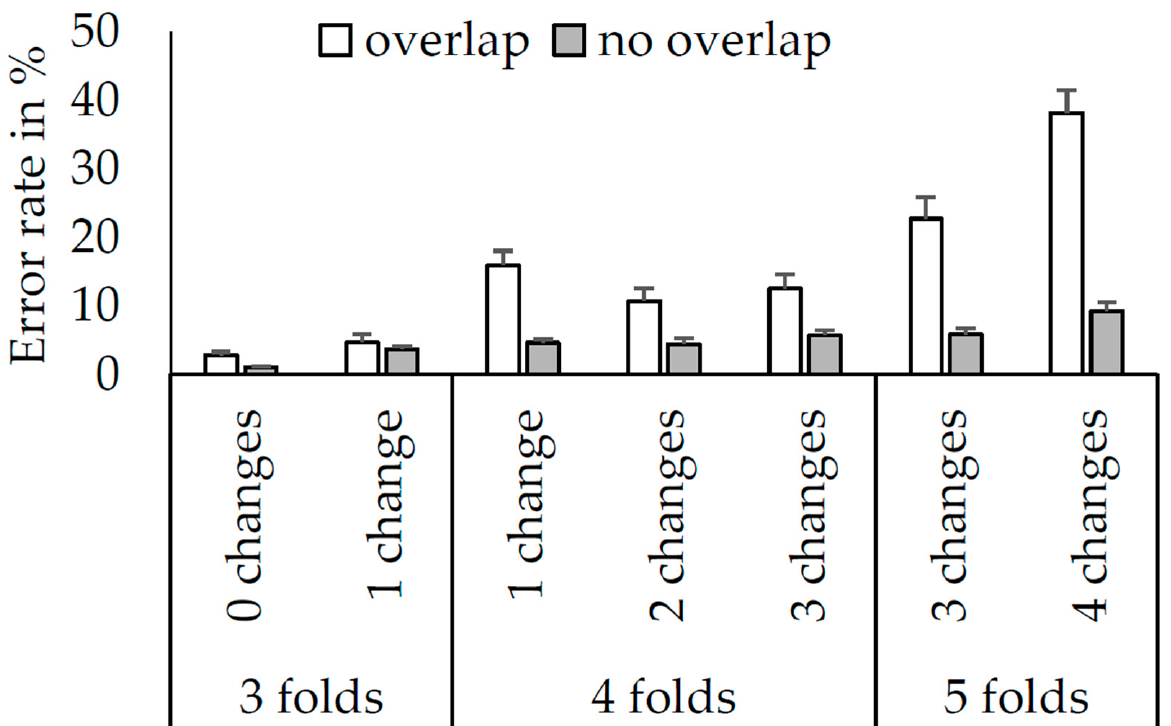
Figure 3. Means and standard errors of error rates (in %), depending on the number of relevant folds (3, 4, or 5), the number of directional changes (0, 1, 2, 3, or 4), and whether the highlighted lines overlap in the cube (overlap or no overlap). To maintain an equal number of factor levels, the values of four folds and two changes were not used in the ANOVA. Table 2. Statistical results of the ANOVA for error rates. The ANOVA was conducted with the factors overlap , folds , and directional changes .